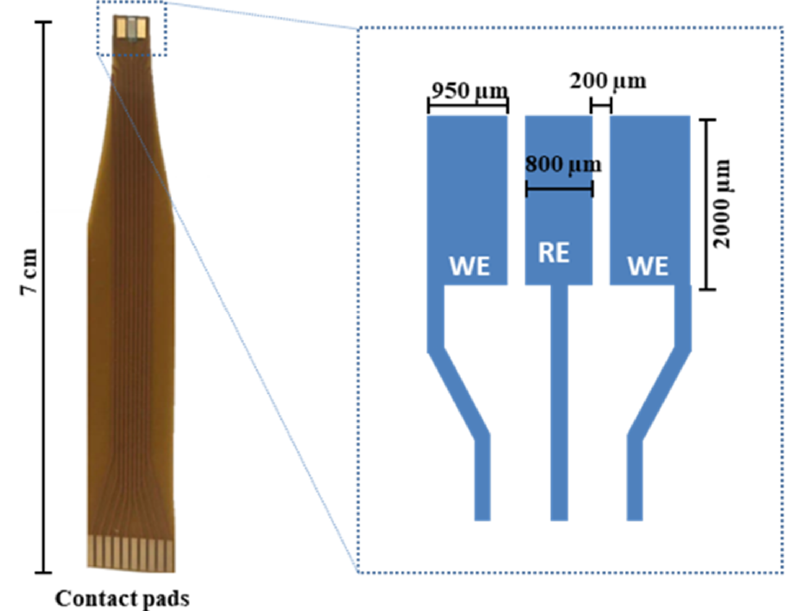
Figure 1. Flexible ion selective electrodes. Photograph of the ion selective sensor on flexible Kapton substrate (70 × 4 mm 2 tapered tip) and close-up schematic image of the sensitive area structure of sensor. Two different working electrodes supported by a common Ag/AgCl reference allow detection of two different ions.